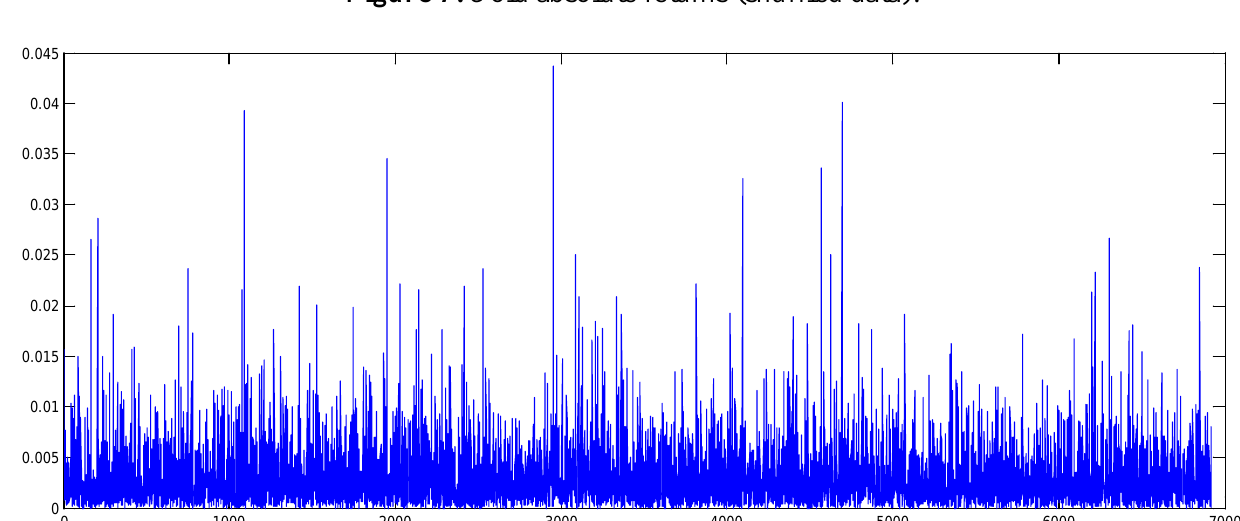
Figure 7. Gold absolute returns (shuffled